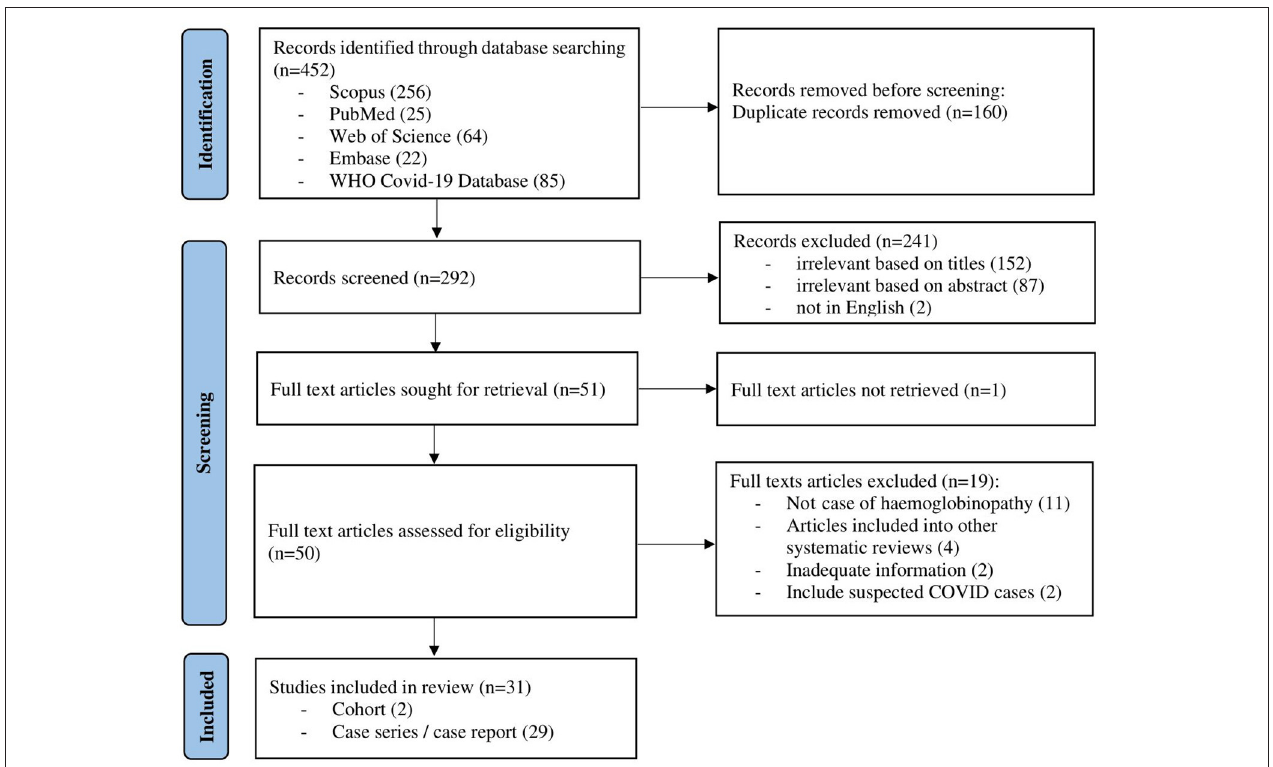
FIGURE 1 | Flow chart of study selection process (flow chart adapted from